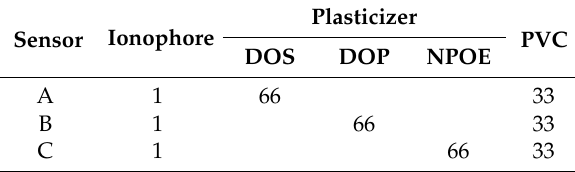
Table 1. Membrane composition (% w / w ) of the platinum porphyrin based sensors. Sensor Ionophore